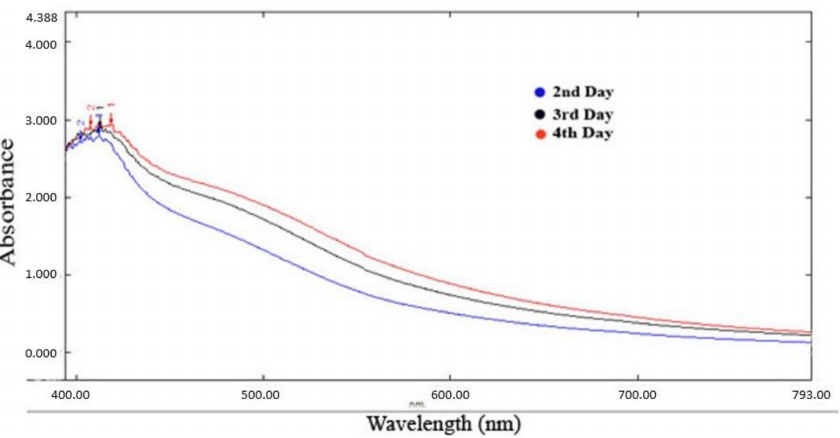
Figure 2. UV-visible spectra Psidium guajava nanoparticles.